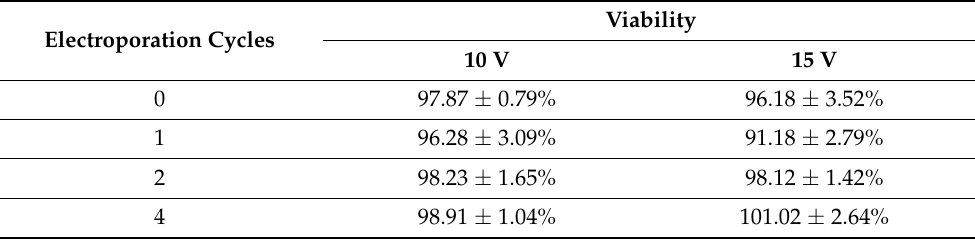
Table 3. The data of cell viability after 0, 1, 2, and 4 cycles of repeated nanostraw-electroporation. Electroporation Cycles